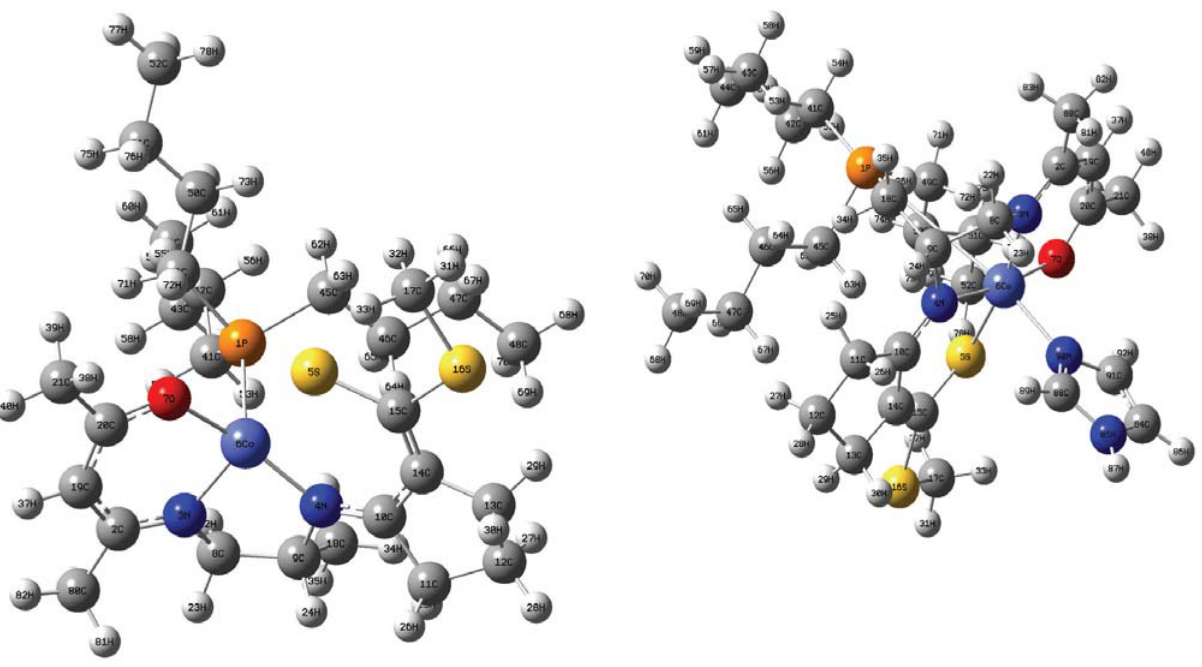
Figure 4. The optimized structures of [ Co(cdacacen)(PBu